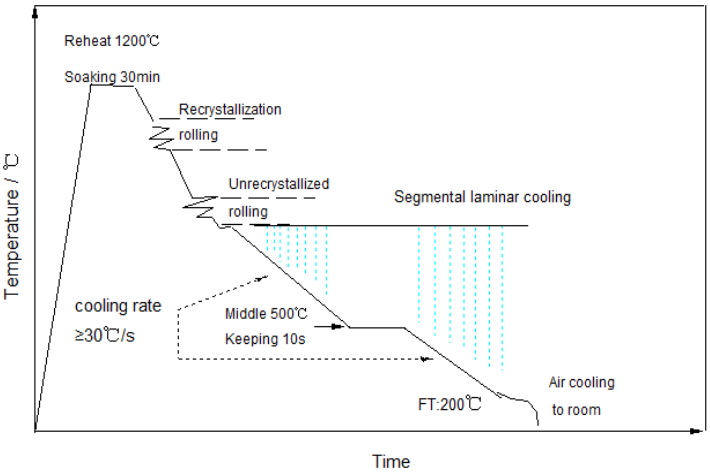
Figure 1. Diagram of the DQ&P&T rolling process of tested steel.